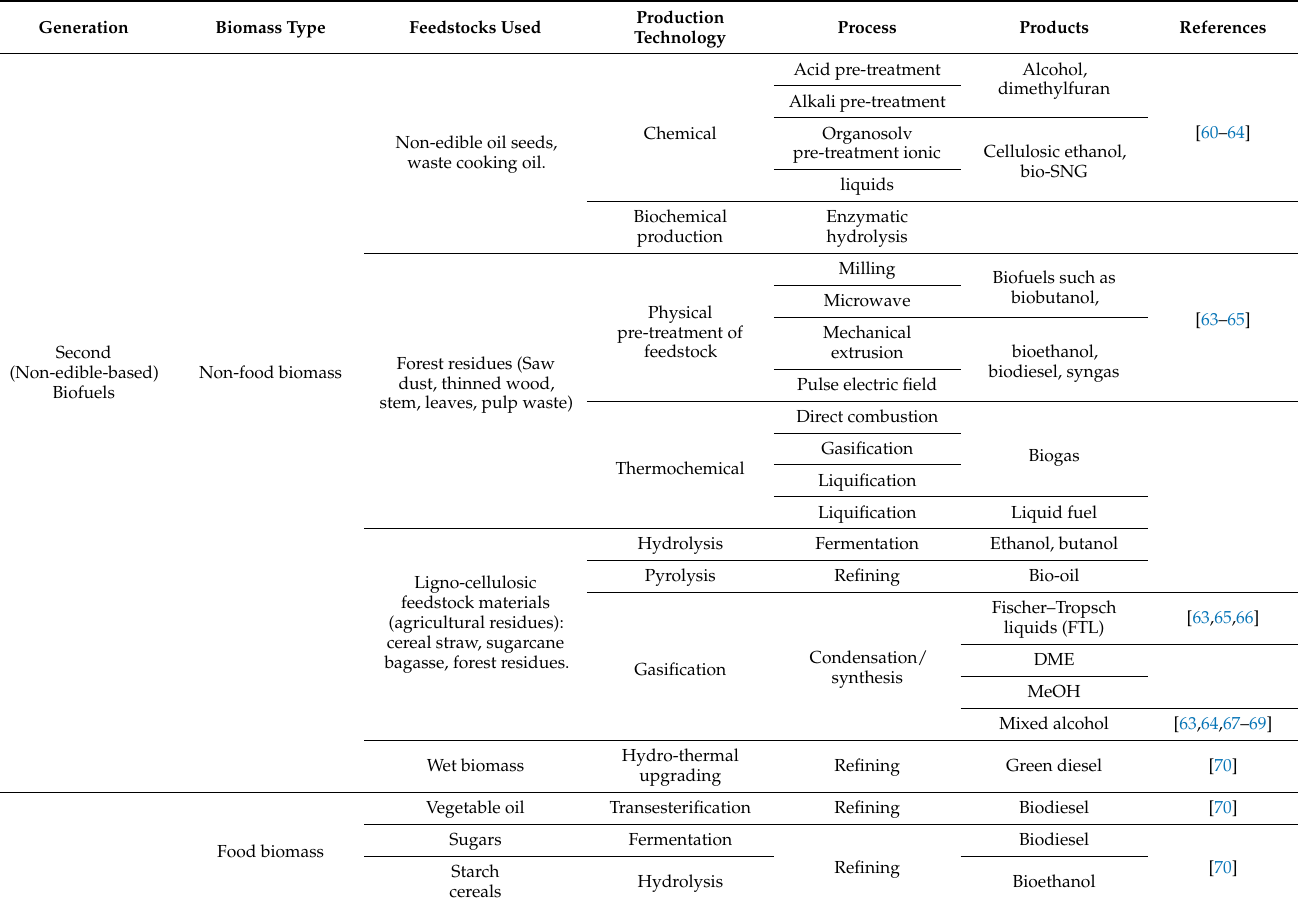
Table 1. Comprehensive overview of the technology used for the production of second-generation